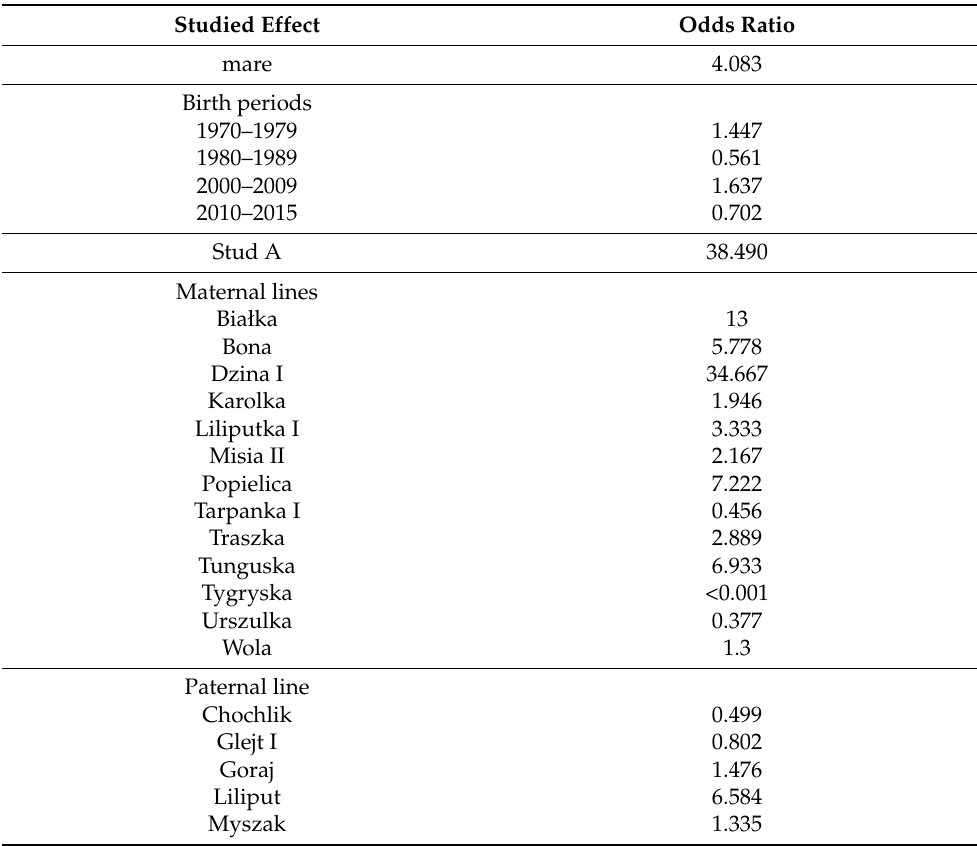
Table 5. Estimates of odds ratio for predisposition to asthma diseases in logistic